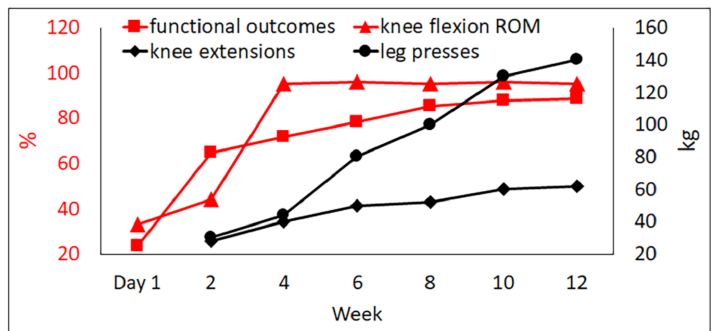
Figure 3. Progression of postoperative interventions (red lines and font) and external loads of resistance exercises (black lines and font). Note that functional outcomes are the average percentages of the scores from the Kujala anterior knee pain scale, International Knee Documentation Committee score, and lower-extremity functional scale. Knee flexion ROM was the percentage of full ROM, 131 ◦ measured at initial evaluation and day 0 (the day before surgery). Day 1 indicates the first day of postoperative rehabilitation. ROM: range of